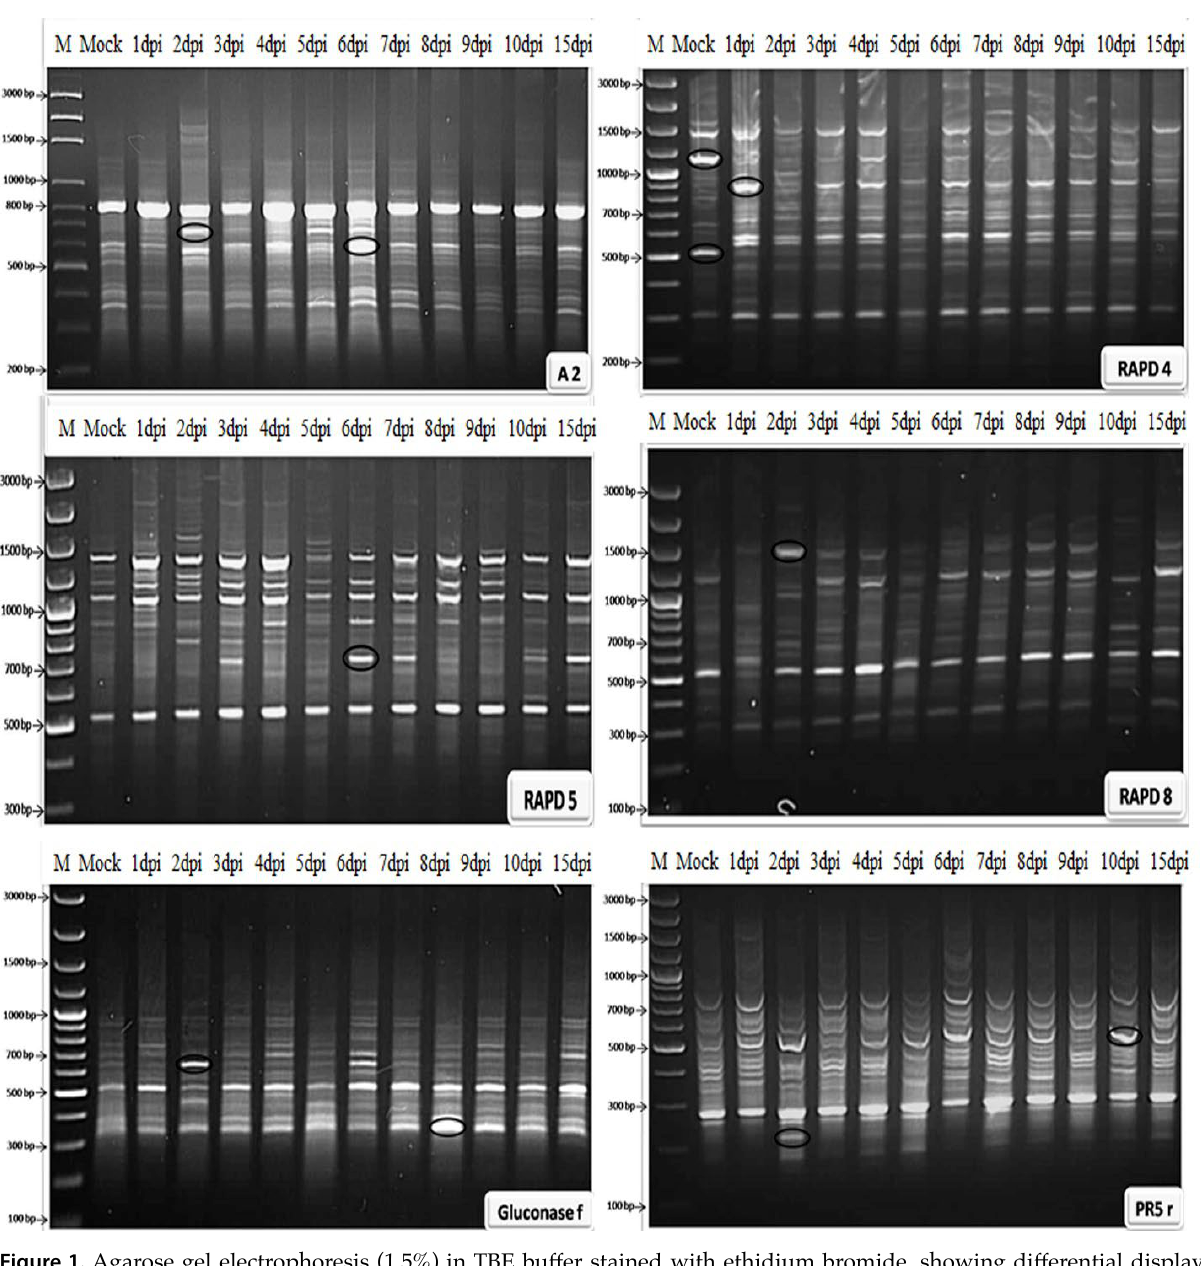
Figure 1. Agarose gel electrophoresis (1.5%) in TBE buffer stained with ethidium bromide, showing differential display PCR using primers A2, RAPD 4, RAPD 5, RAPD 8, Gluconase-f and PR5-r. Lane M, DNA marker 100 bp ladder; lane “Mock” control (mock-inoculated plant tissues); lanes 1 dpi to 15 dpi, plant tissues collected at 1, 2, 3, 4, 5, 6, 7, 8, 9, 10 and 15 d post inoculation with Iris yellow spot virus . Black ovals indicate the bands that were